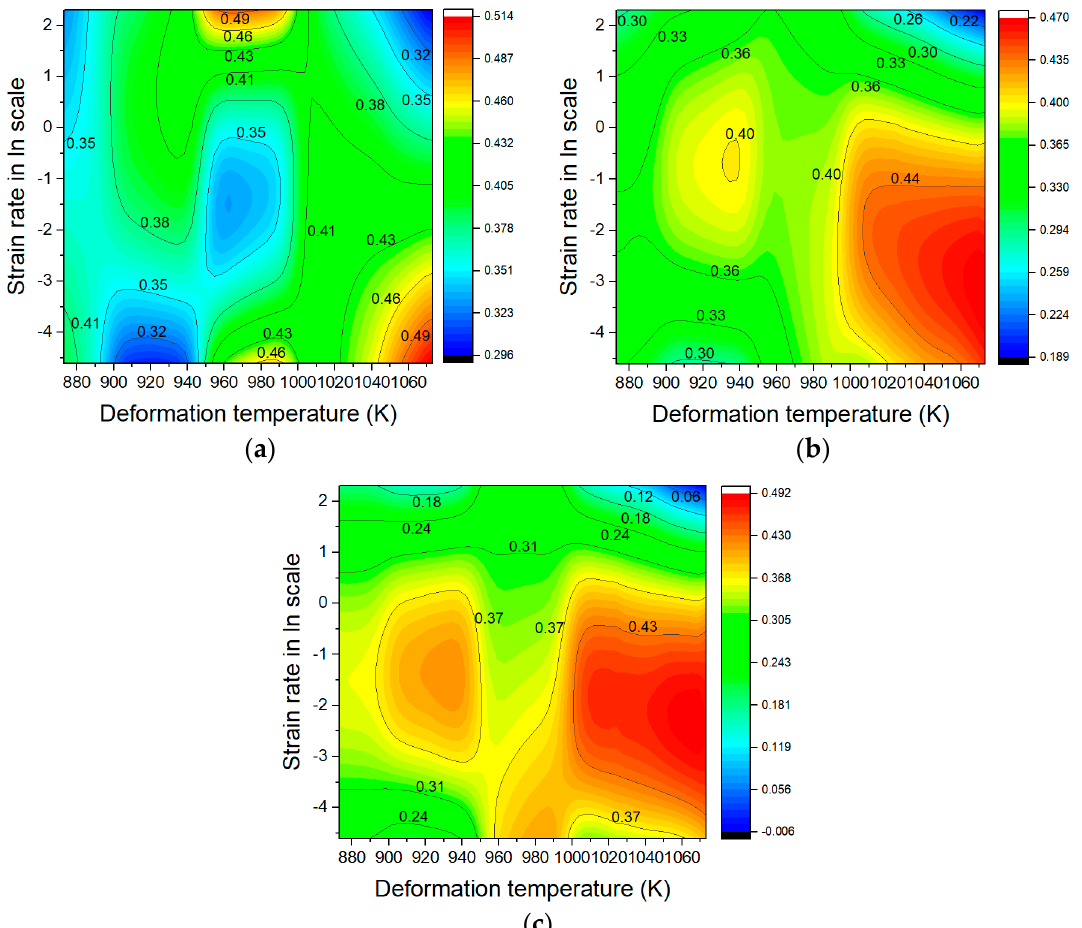
Figure 8. The contour maps of power dissipation η at various strain levels: ( a ) strain at 0.3, ( b ) strain at 0.6, ( c ) strain at 0.9.